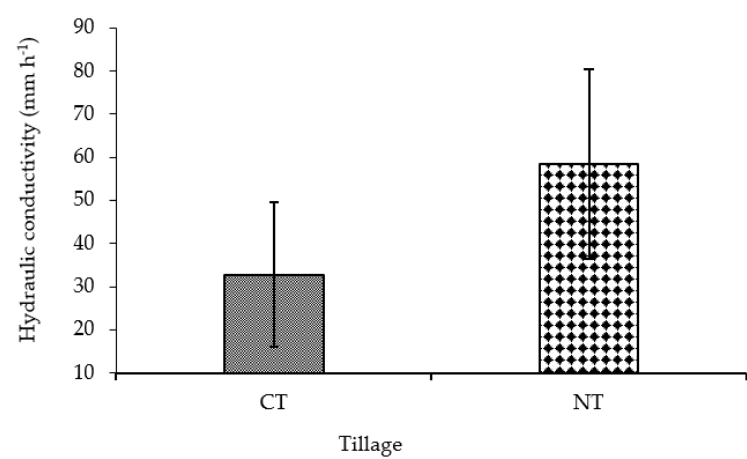
Figure 3. Effects of tillage on hydraulic conductivity at the 0–0.15 m soil depth after 3 years of cropping. Error bars indicate standard deviation. CT is conventional tillage and NT is no-till.